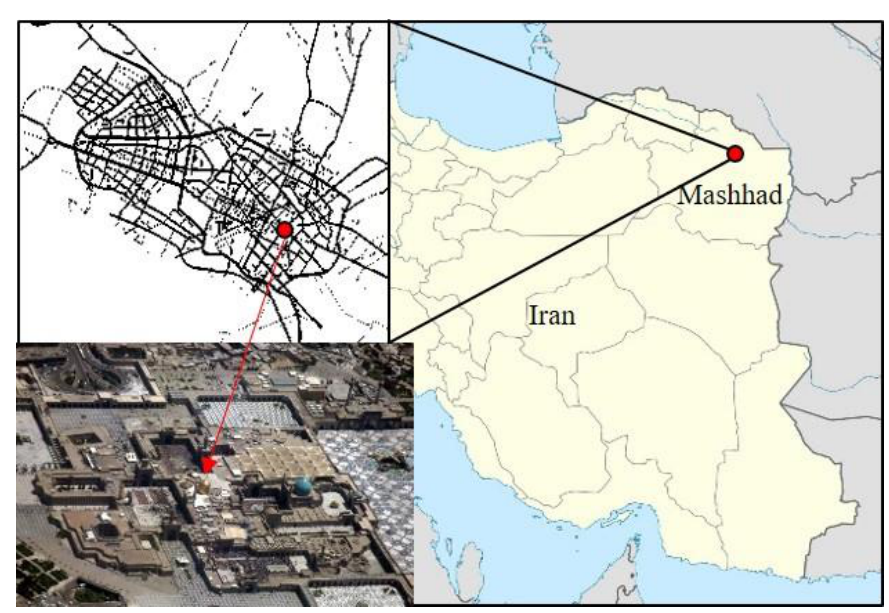
Figure 6 Location of Holy Shrine and Mashhad in